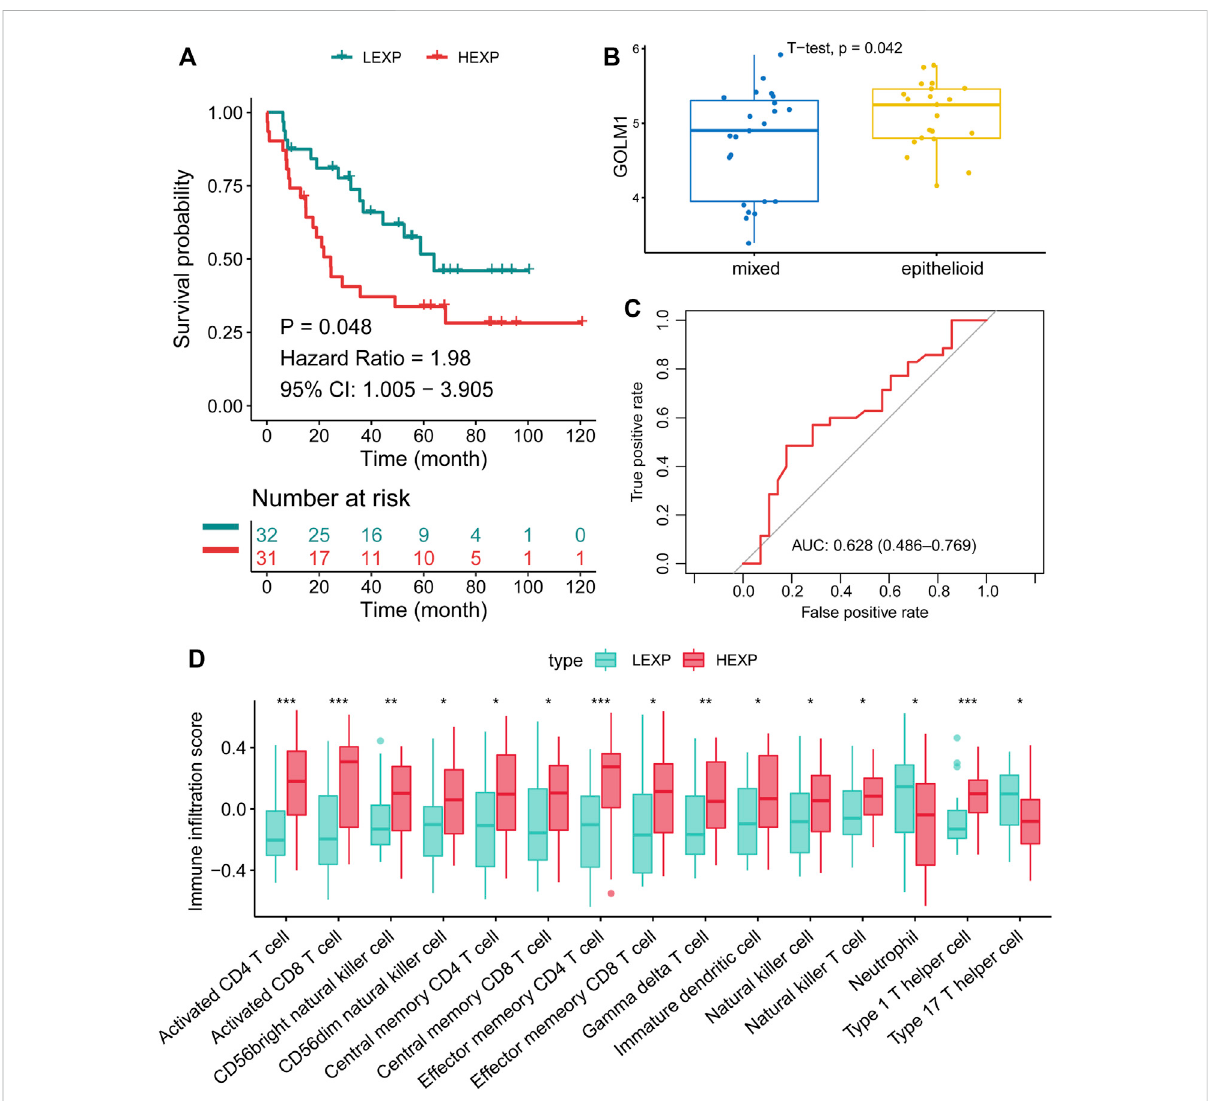
FIGURE 5 Con fi rmation of the prognostic value of GOLM1 in the GSE21138 cohort. (A) Kaplan – Meier curve showing the polarized overall survival in GOLM1-low (LEXP) and GOLM1-high (HEXP) subgroups; (B) Differential expression of GOLM1 in epithelioid tumors and mixed tumors; (C) Receiver operating characteristic curve showing the prognostic value of GOLM1; (D) Differential in fi ltration of immunocytes in the LEXP and HEXP